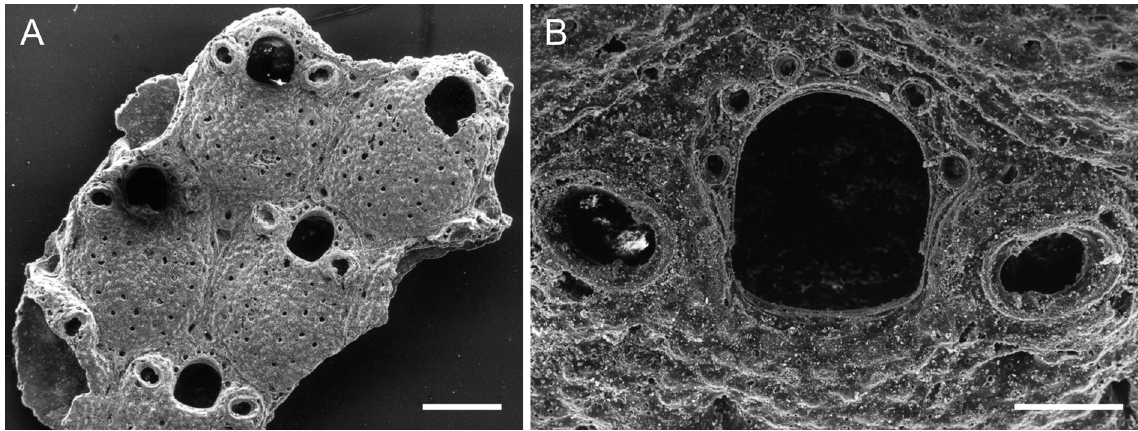
Fig. 15. Calvetopora sp., Great Meteor Bank, OLL 2016/157. A . Overview of colony fragment. B . Close- up of orifice and avicularia. Scale bars: A = 300 µm, B = 100